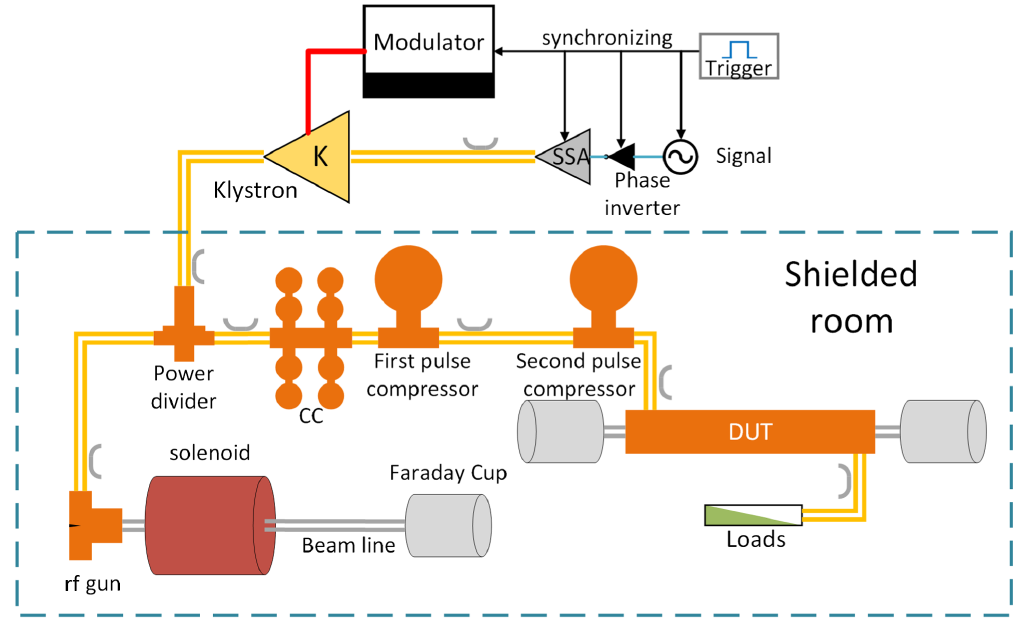
FIG. 12. System diagram of Tsinghua high-power test stand (TPOT-X) with the two-stage pulse compression system